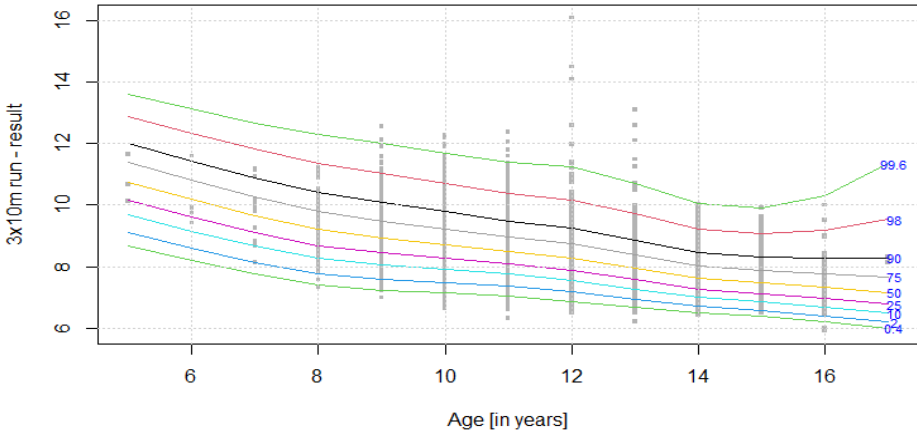
Figure 1. Centile chart for 3 × 10 m run in boys. Table 4. Values of particular centiles for 3 × 10 m run in